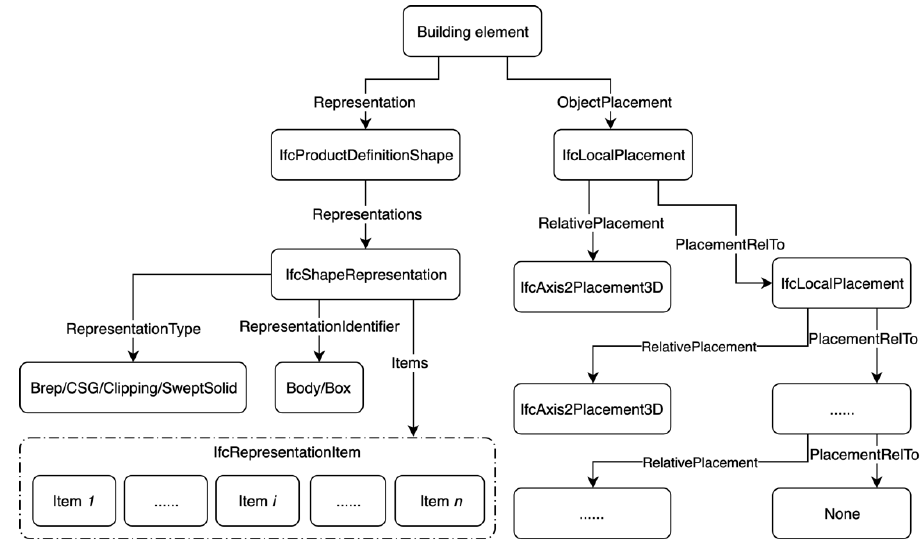
Figure 4. Representation and placement of a typical building element.